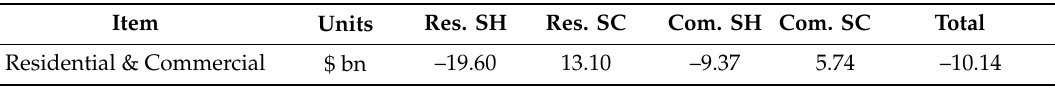
Table 1. Impact of a 3 ◦ C GMST increase on US annual space heating and space cooling expenditure, 2010 US$ billion (negative values are